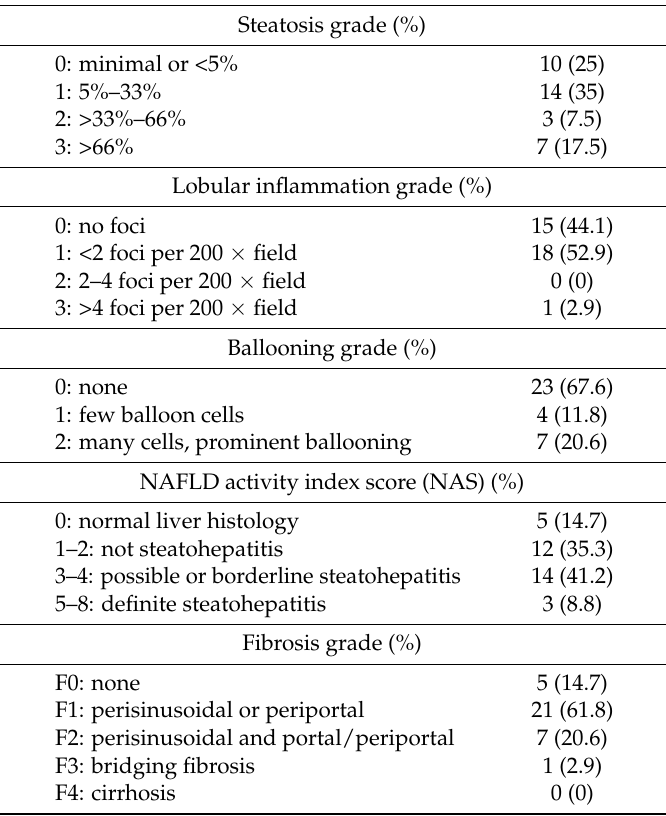
Table 2. Liver histology classification. Liver biopsies were evaluated following non-alcoholic fatty liver disease (NAFLD) features proposed by Brunt and subsequently classified according to the NAFLD activity index validated by Kleiner. Fibrosis was evaluated in biopsy slides stained in Masson trichrome. Data are presented as n and percentage in